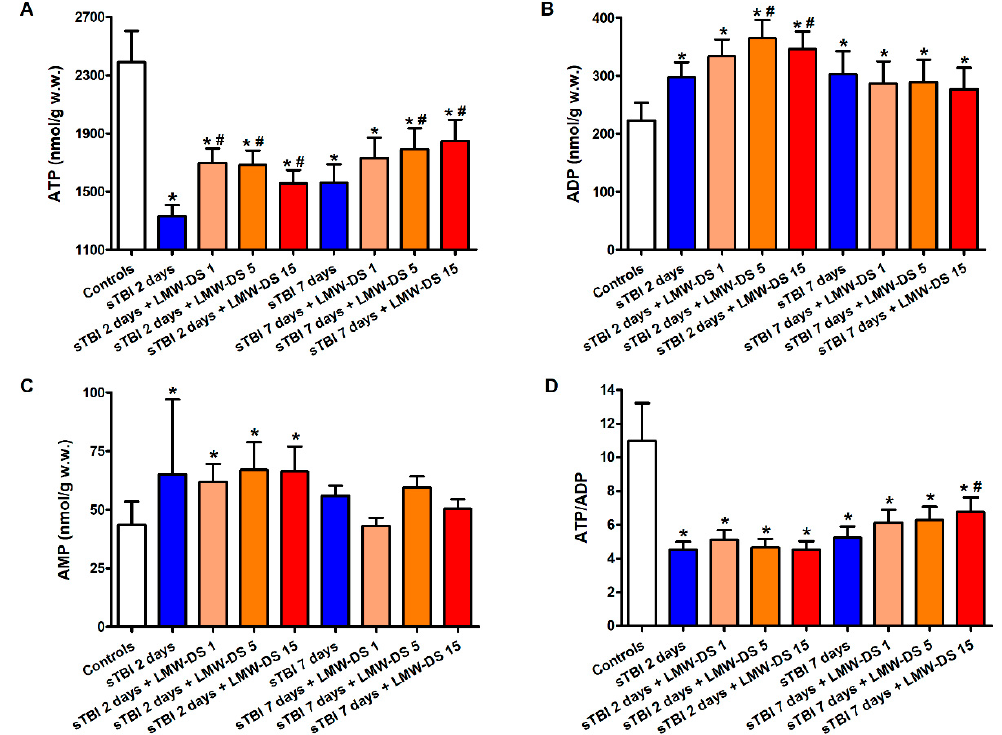
Figure 1. Effect of subcutaneous injection of increasing doses of LMW-DS (ILB ® ) on the cerebral concentrations of ATP ( A ), ADP ( B ), and AMP ( C ), and the ATP/ADP ratio ( D ), as a valuable indicator of the mitochondrial phosphorylating capacity. The parameters of interest were determined by high-performance liquid chromatography (HPLC) of deproteinized cerebral homogenates (at 2 and 7 days post-sTBI), both in untreated sTBI rats (TBI 2 days and TBI 7 days) and in rats receiving 1, 5, or 15 mg/kg b.w. LMW-DS (ILB ® ) administered 30 min after sTBI. Controls are represented by sham-operated rats. Values are the mean ± SD of 12 different animals and are expressed as nmol/g w.w. * Significantly different from sham-operated control rats, p < 0.05. # Significantly different from the corresponding time point of untreated sTBI rats, p < 0.05.